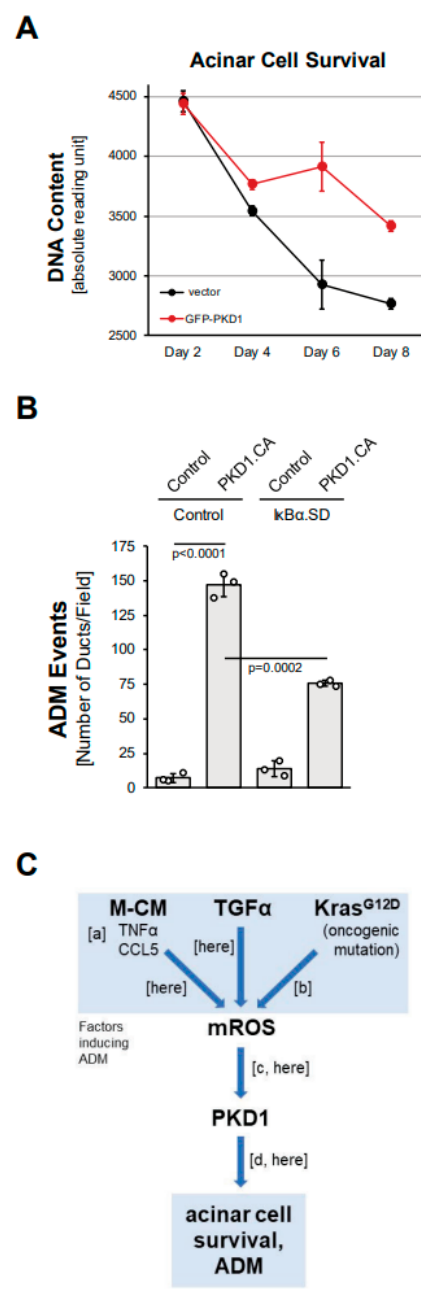
Figure 5. PKD1 increases acinar cell survival and drives ADM through canonical NF- κ B signaling. ( A ): Primary mouse acinar cells were isolated, lentivirally-infected with control vector or GFP-tagged PKD1, and then subjected to a CyQUANT Cell Proliferation Assay kit over the indicated time period. ( B ): Mouse pancreatic acinar cells were isolated, adenovirally-infected with control virus or superdominant I κ B α (I κ B α .SD) and lentivirally-infected with control or GFP-PKD1.CA (GFP-PKD1.SSEE) and then seeded in 3D collagen culture. ADM and ducts formed were quantified as described in the Methods section. ( C ): Schematic summarizing current data and previously published work, demonstrating how ROS-PKD1 signaling is a key factor downstream of different inducers of acinar-to-ductal (ADM) metaplasia. Macrophage-conditioned medium (M-CM) with its two major drivers TNF α and CCL5 (published in [10]; (a)), TGF α (here), or expression of oncogenic KRAS (published in [15]; (b)) all induce mitochondrial reactive oxygen species (mROS), which have been shown to activate PKD1 (published in [17]; [c] and (here)). PKD1 is a key driver of ADM (published in [14]; (d) and (here)).